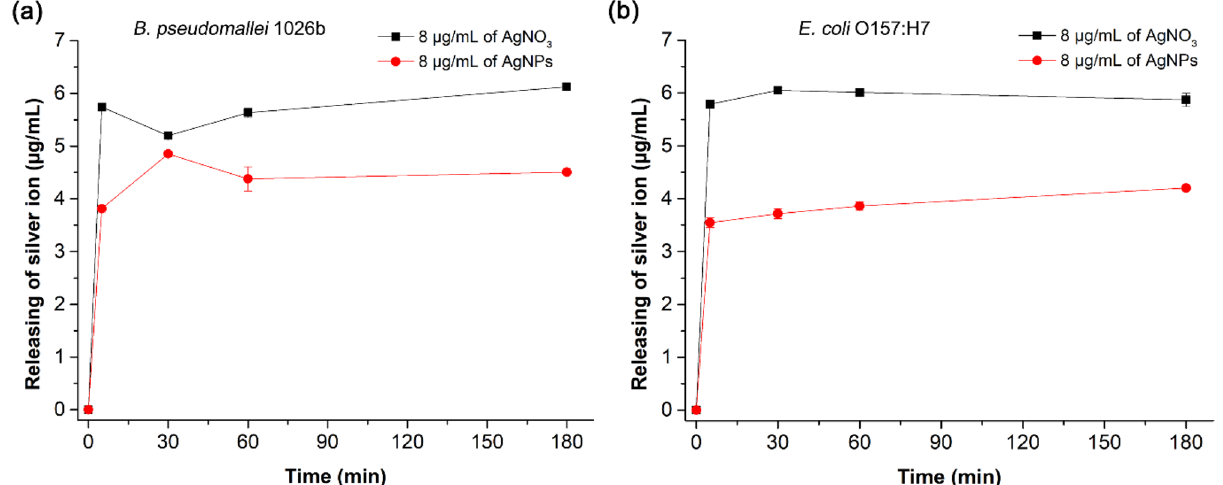
Figure 5. Silver ion release upon incubation of andro-AgNPs and AgNO 3 with B. pseudomallei 1026b ( a ) and E. coli O157:H7 ( b ). The bacteria were treated with AgNPs or AgNO 3 at 1xMBC for 0, 5, 30, 60, 180 min. The incubate was filtered using centrifugal membrane 30 K and the flow-through fraction examined for silver ion concentration by ICP-OES. Data represents the mean ± standard error from two independent experiments performed in triplicate (n =